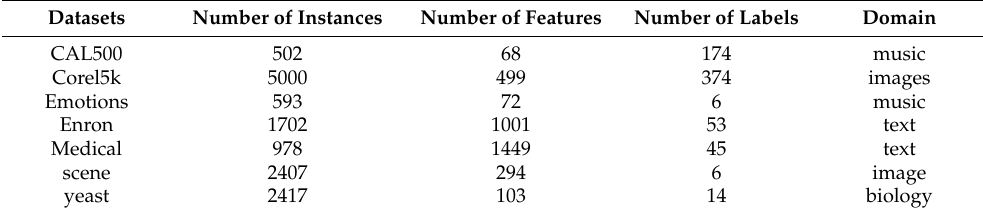
Table 2. Statistics of multi-label benchmark datasets.